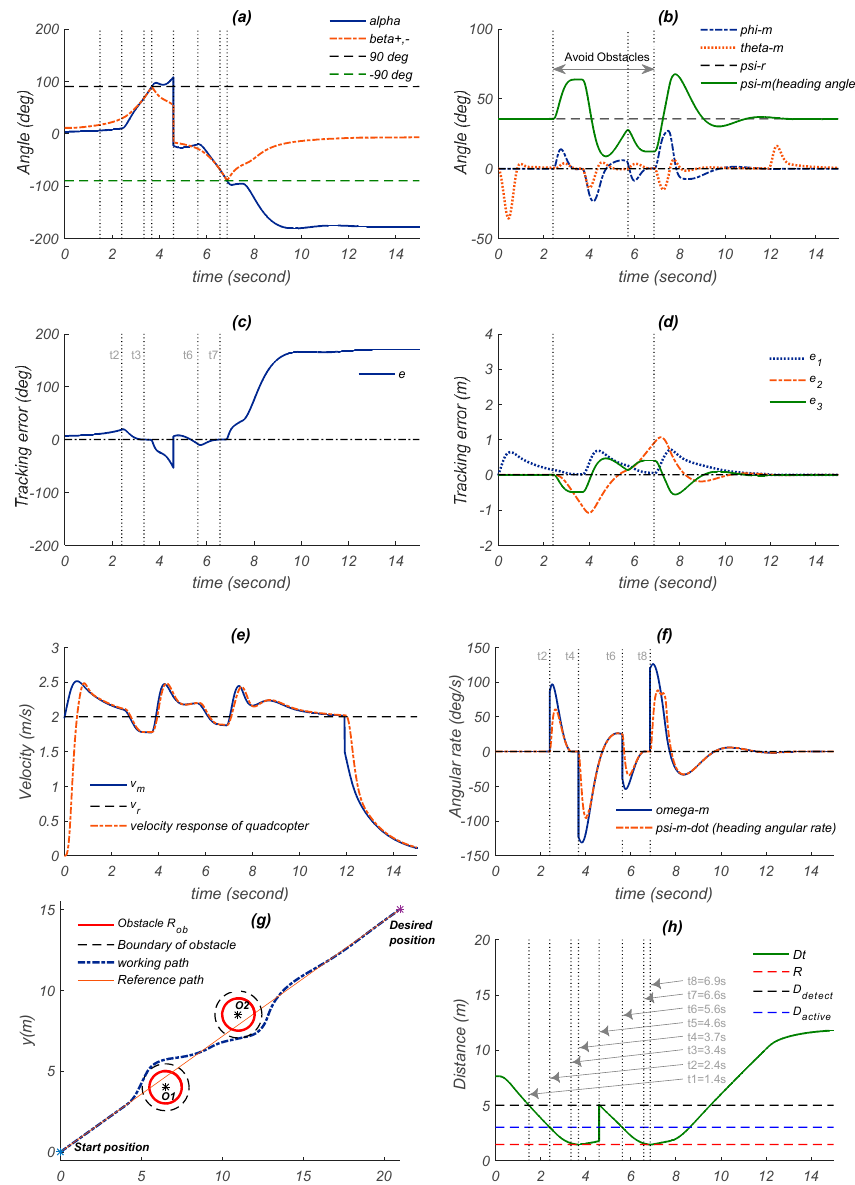
Figure 7. Example 1, the reference path is a straight-line and obstacles were placed at O1 (6.5, 4) and O2 (11, 8.5): ( a ) Angle α tracking β ± ; ( b ) Attitude performance; ( c ) The angular tracking error e; ( d ) The position tracking error e1, e2, e3; ( e ) The velocity performance of the vehicle; ( f ) Heading angular rate; ( g ) The performance of the working path in 2D; ( h ) The relative distance between the vehicle and the obstacle.